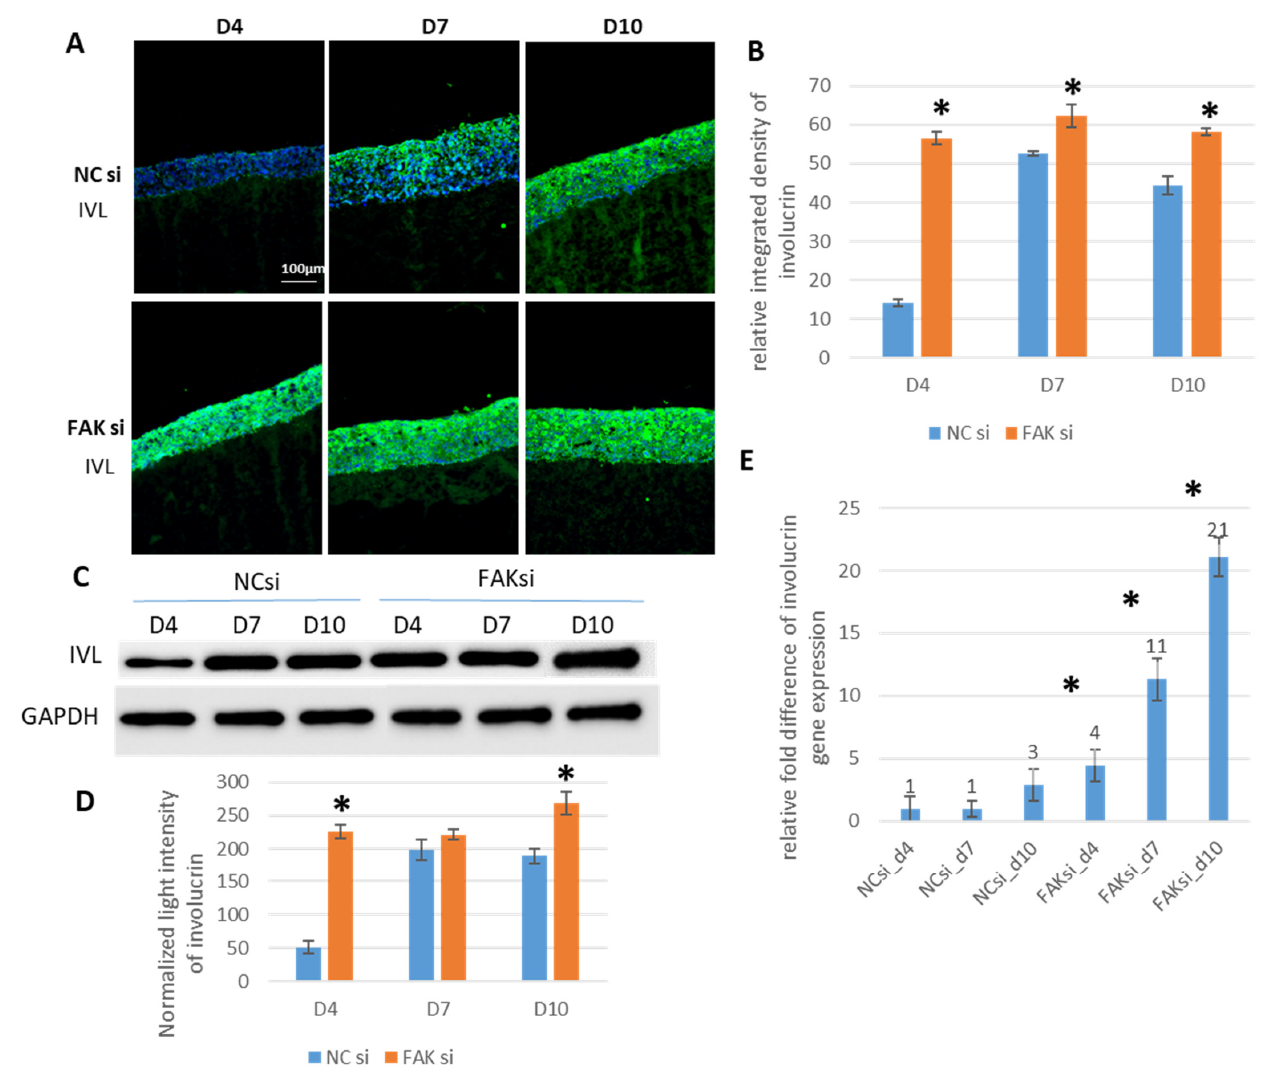
Figure 4. siRNA-mediated inhibition of FAK in GK-based cocultures and the influence on involucrin (IVL) expression and distribution. Cells were transfected with FAK-siRNA and incubated for 48 h before usage in the coculture setup for a further 4, 7, or 10 days. Shown in ( A ) are representative IIF images of cryofixed sections of FAK-siRNA-treated versus nontreated cocultures, stained with an anti-involucrin antibody after the indicated periods of time (4, 7, or 10 days). The bar graph in ( B ) shows the corresponding SQFI analysis by measuring the relative integrated fluorescence density of the involucrin fluorescence signal and compares the FAK-siRNA inhibited coculture with the noninhibited control. Shown in ( C ) is a representative Western blot of whole cell lysates from keratinocytes depicting the protein amount of involucrin in FAK-siRNA inhibited cocultures and the noninhibited controls together with the loading control GAPDH at the indicated points of time. The bar graph in ( D ) illustrates the involucrin Western blot quantification by measuring the normalized light intensity of the respective bands. ( E ) Represents the quantitative PCR analysis of the calculated mRNA-expression levels of involucrin as the relative fold difference when compared to the control samples at day 4. ( n = 3 for all experiments, values are depicted as mean +/ − SEM; * = p < 0.05. Scale bars represent 100 µm. NC = negative control; D = day).